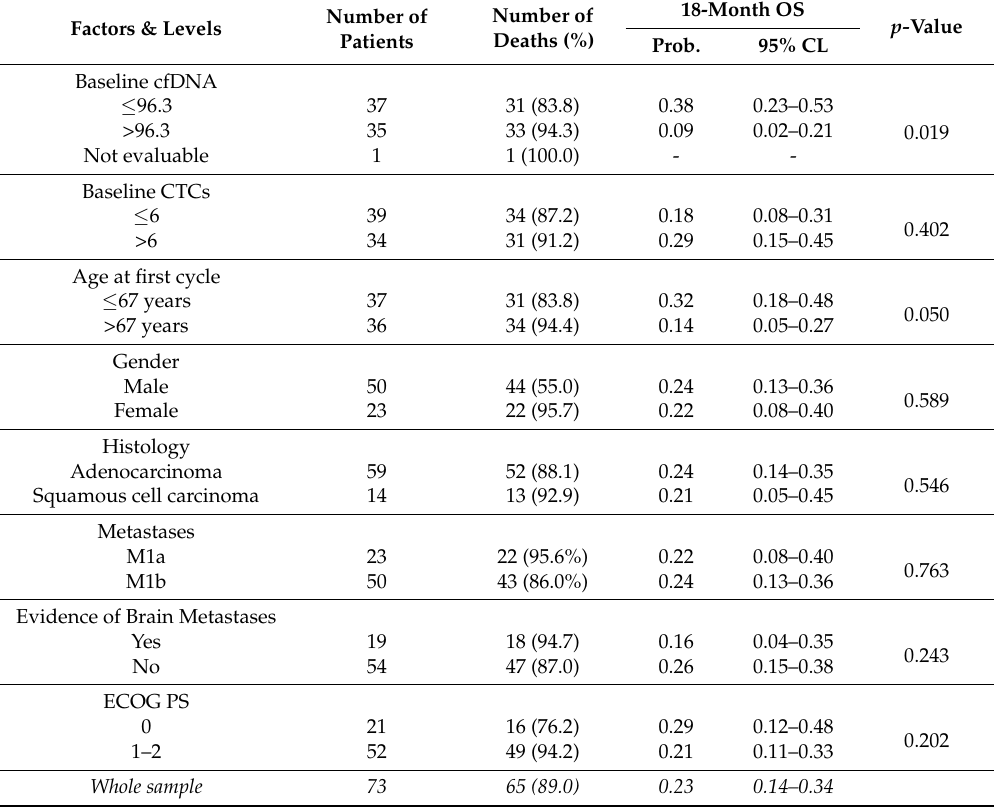
Table 2. Eighteen-month overall survival estimated through the Kaplan–Meier